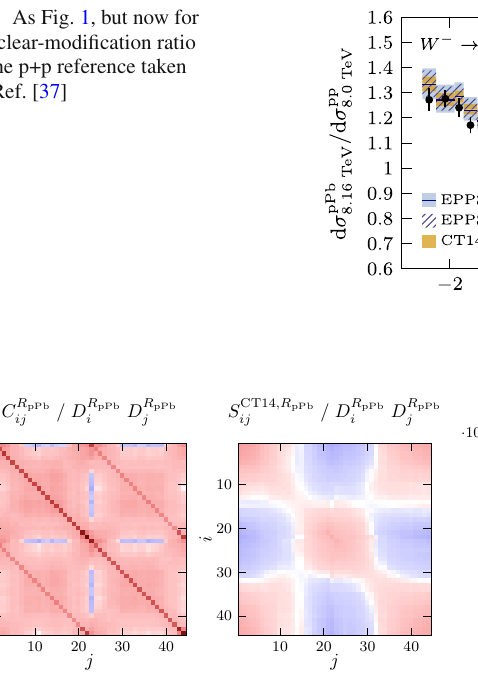
Fig. 10 As Fig. 2, but now for the nuclear-modification ratio with the p+preferencetakenfromRef.[37].Indices i , j followthesameordering as the data points in Fig. 9, with the indices 1 through 22 corresponding to the W − production and 23 through 44 to W